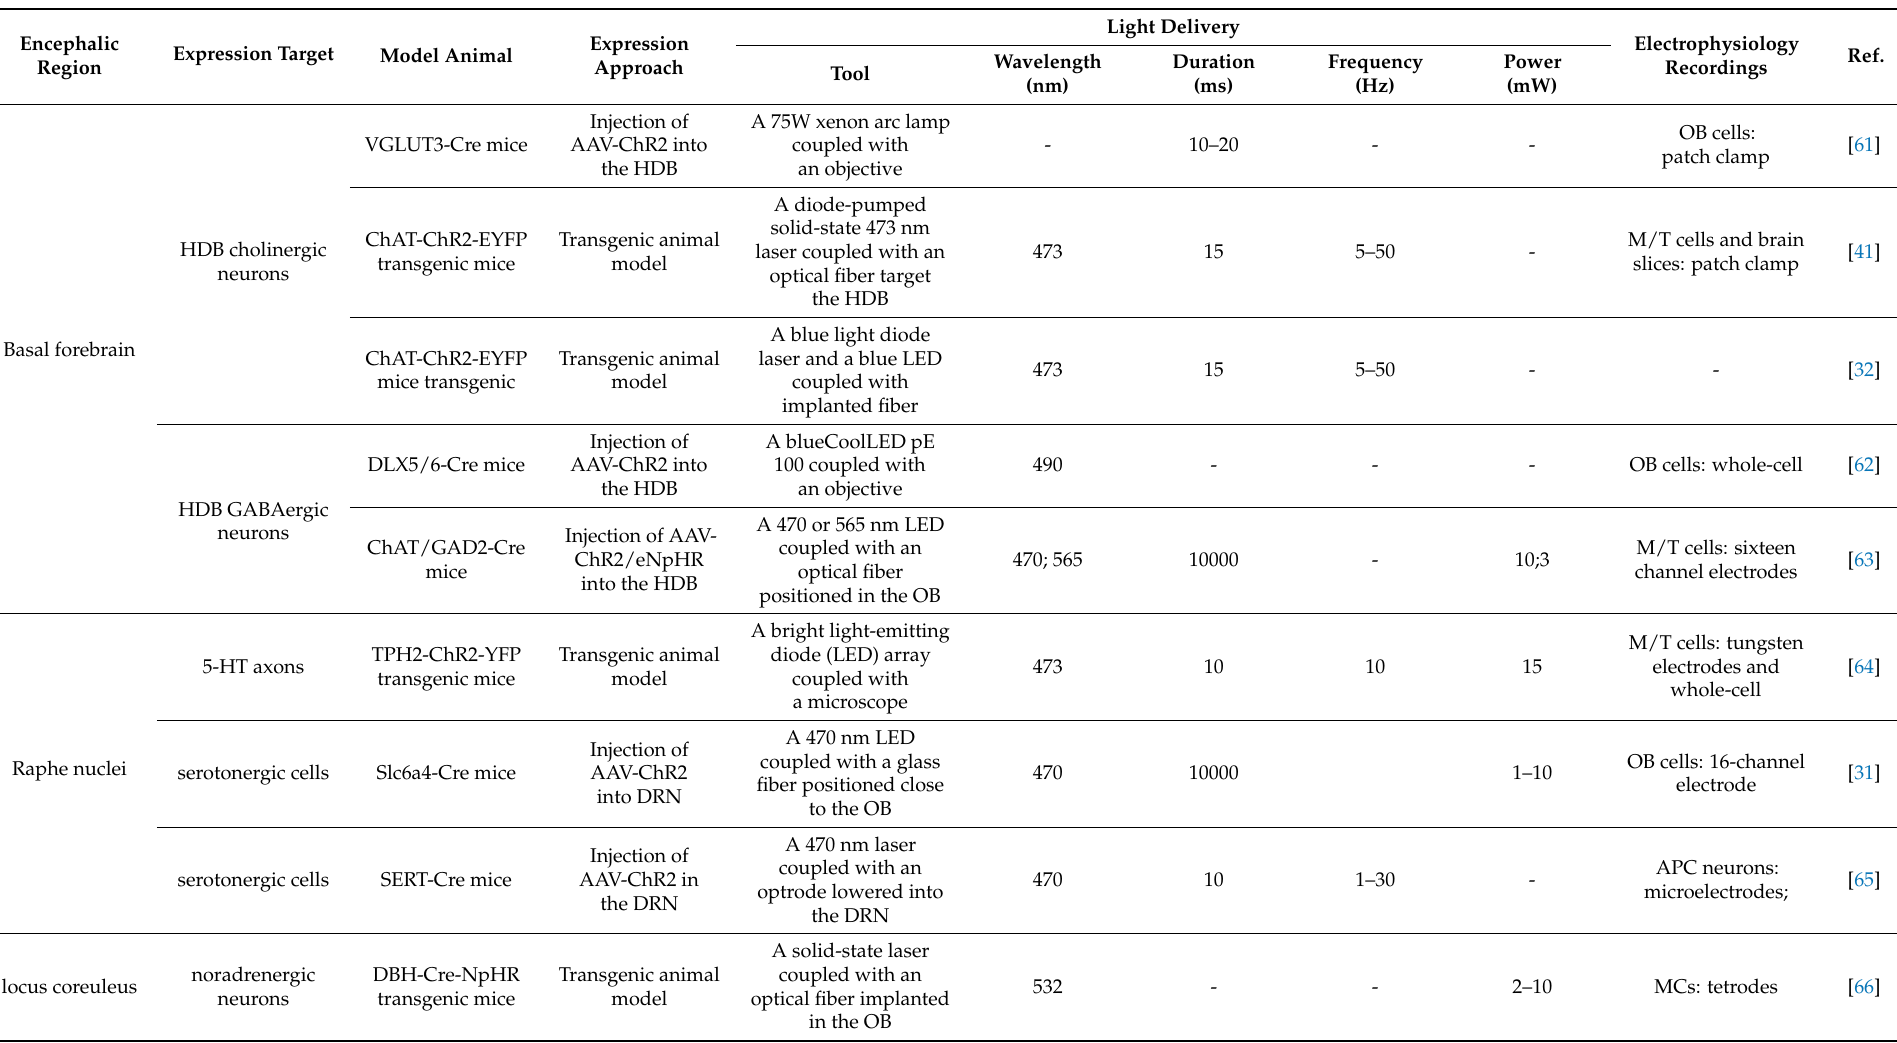
Table 2. Optogenetics approach in neuromodulation projections to the